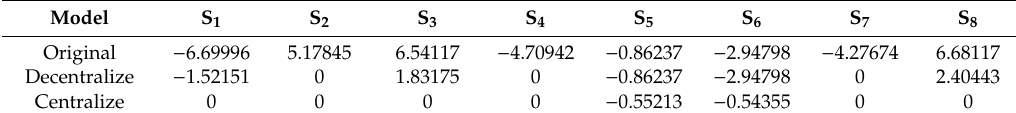
Table 6. Feeder power before and after regulation under case 4 (MW).